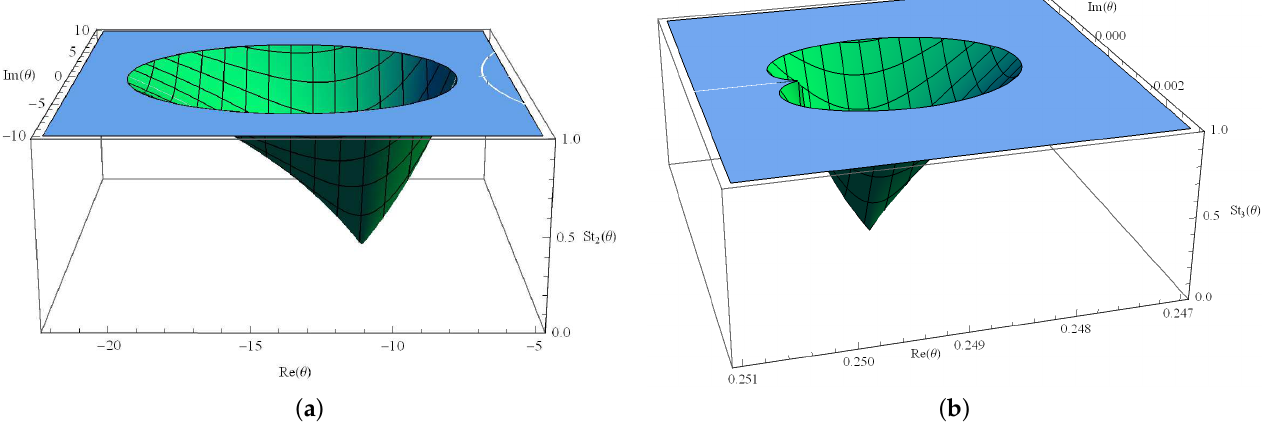
Figure 3. Stability regions. a ) Stability region of exf 1 ( θ ) and exf 2 ( θ ) , ( b ) Stability region of exf 1 ( θ ) and exf 2 ( θ )